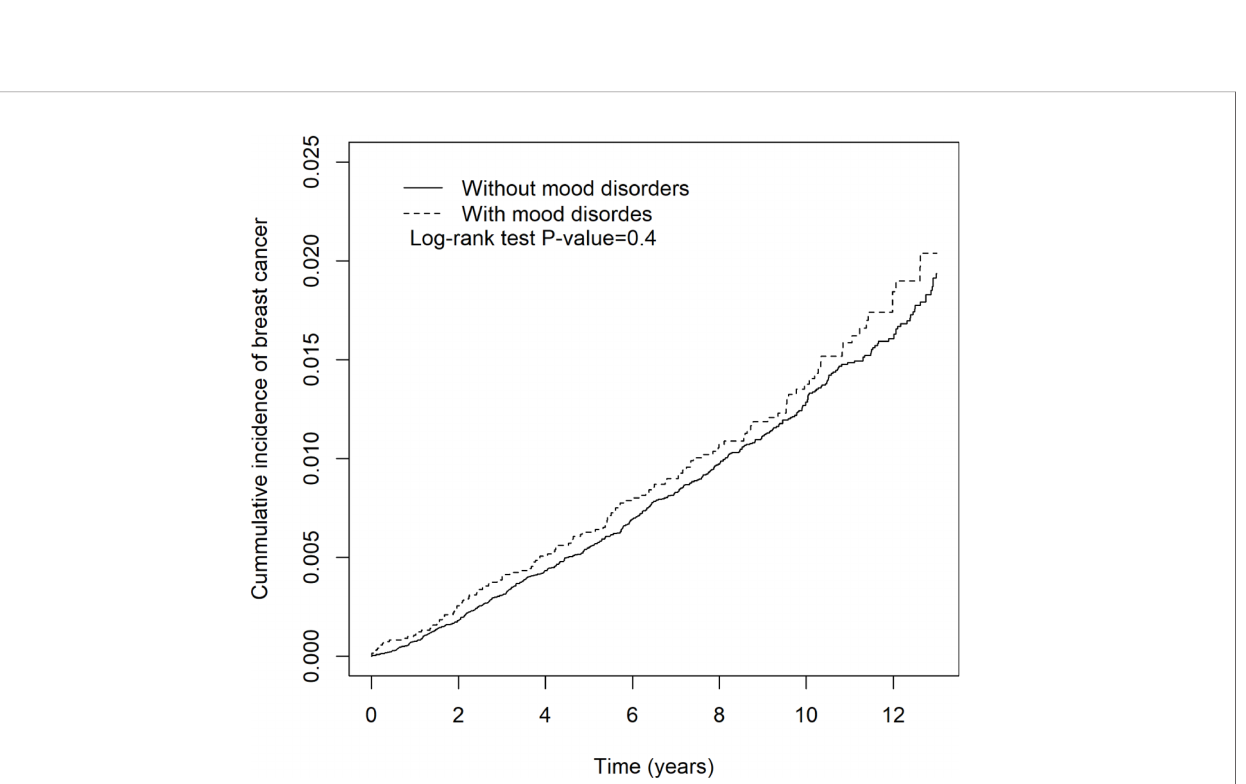
FIGURE 3 | The cumulative incidence of breast cancer in patients with and without depressive disorders.